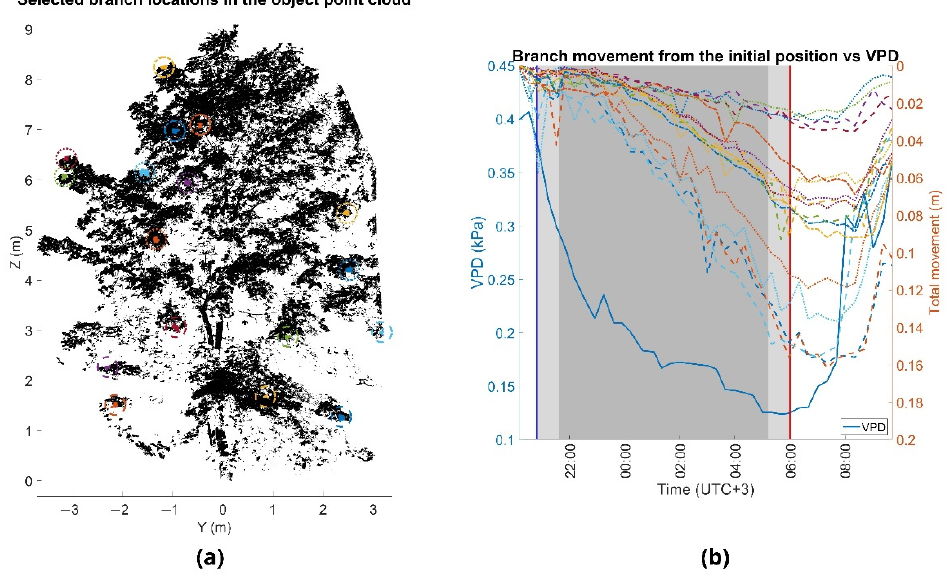
Figure 6. ( a ) Point cloud of the moderate-sized Norway maple ( Acer platanoides L.) in August 2016. ( b ) Overnight branch movement during monitoring period. Branch movements are marked with the dashed lines and the vapor-pressure deficit (VPD) with the solid blue line. The times of sunset and sunrise are marked with the blue and red vertical lines, at 8:40 p.m. and 6:00 a.m., respectively. Civil twilight time is marked with the light gray area, and time of nautical and astronomical twilight with the dark gray area.